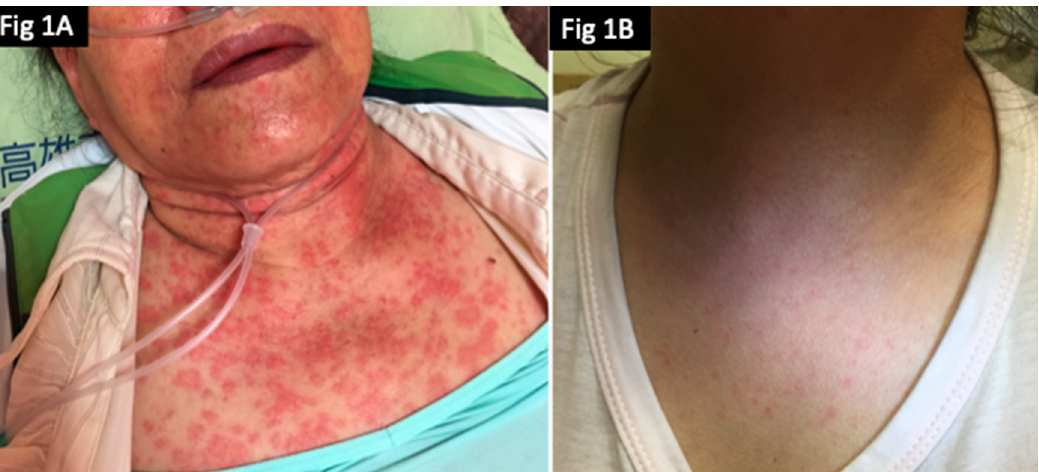
Figure 1. ( A ) Maculopapular rash developed two days later after completing seven-day Gemifloxacin treatment in a 76 years old female patient. ( B ) Exanthematous rash occurred on the final day of the seven-day Gemifloxacin treatment in a 32 years old female patient.